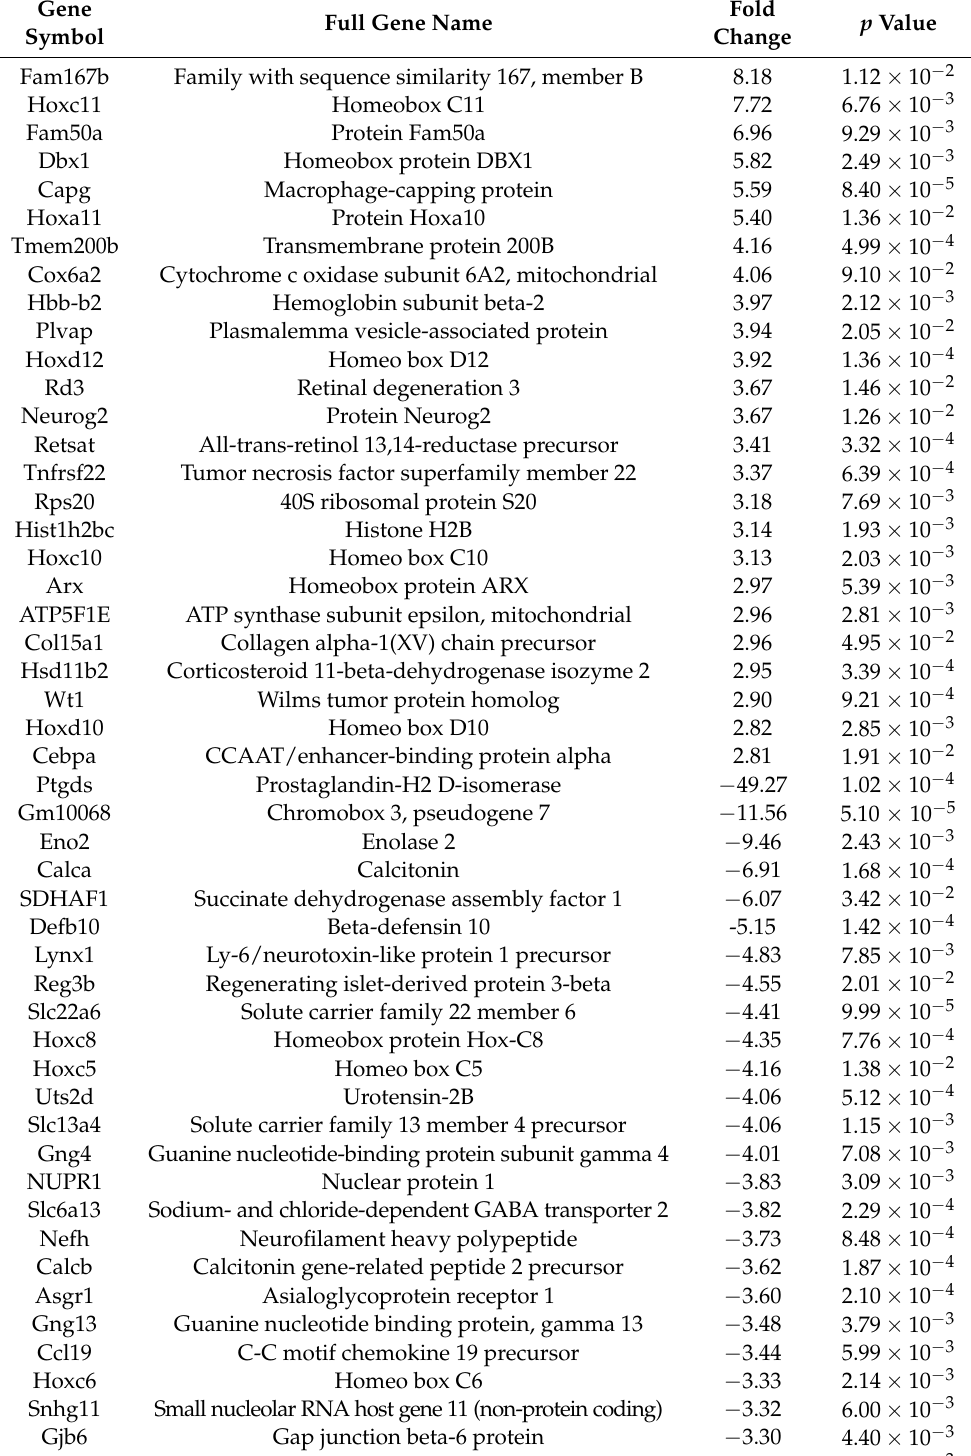
Table 4. Top 25 upregulated and downregulated genes between MMC and vehicle groups at E17.